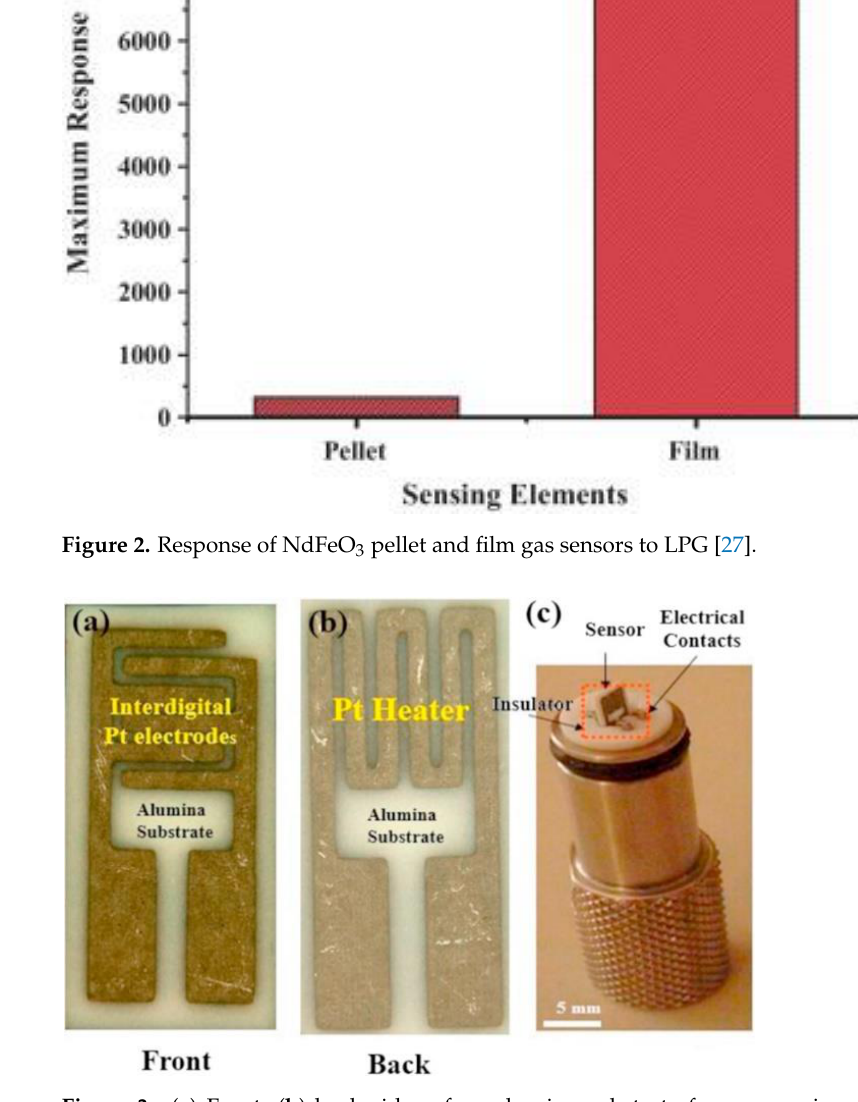
Figure 3. ( a ) Front; ( b ) back sides of an alumina substrate for gas sensing studies; ( c ) Sensor holder [29].